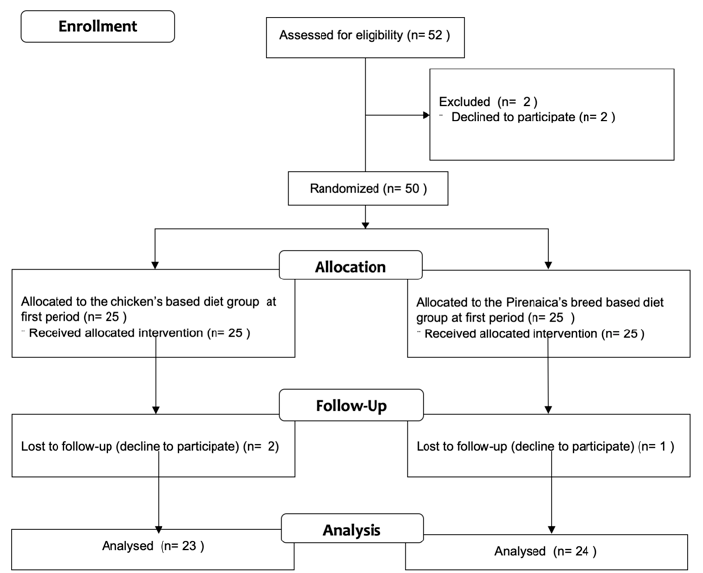
Figure 1. Flow diagram of the recruitment process.